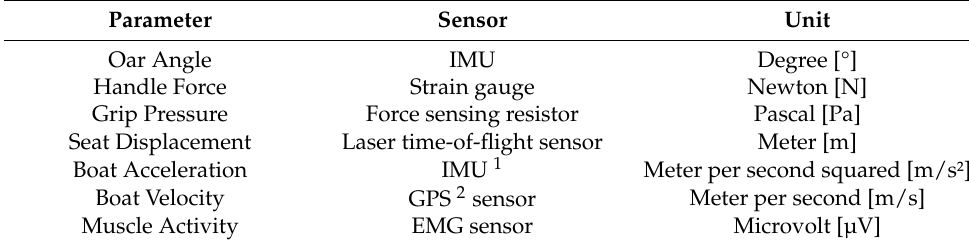
Table 2. Rowing Parameters recorded by